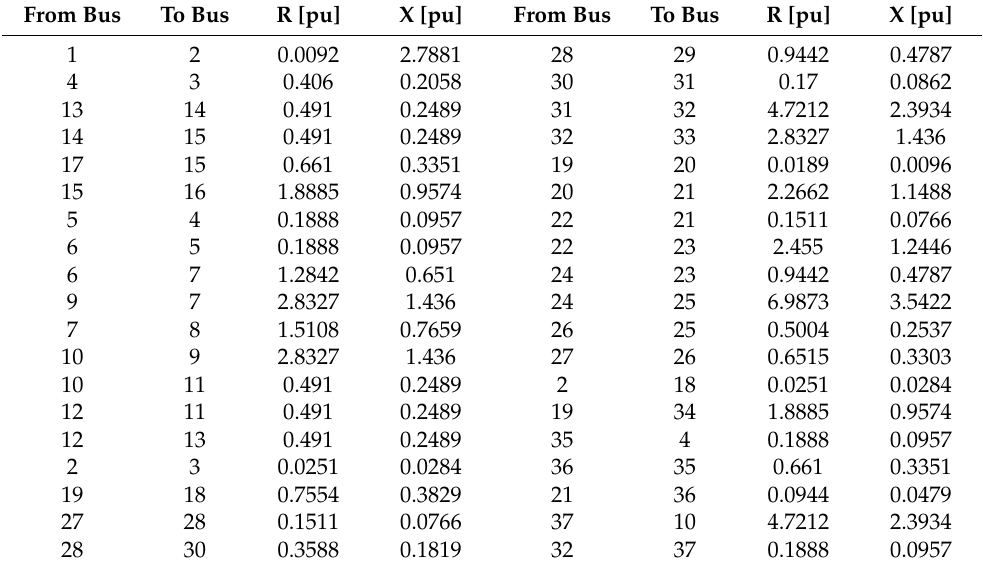
Table A2. Line data of the stand-alone